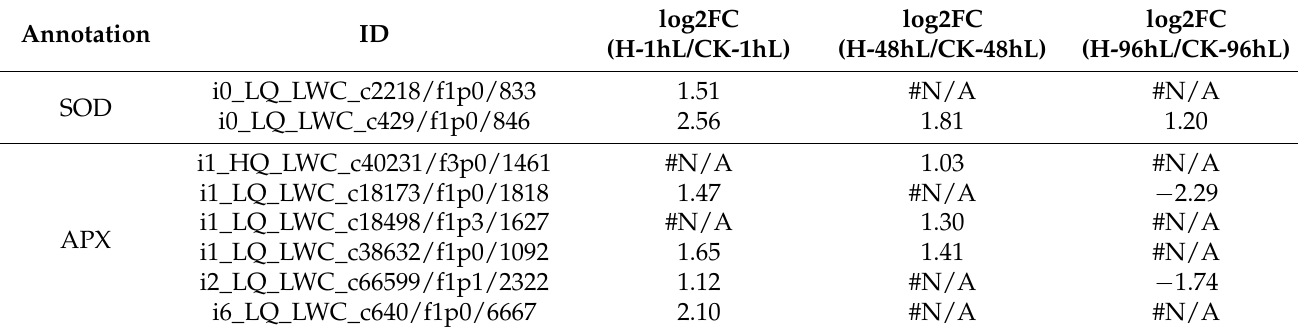
Table 3. Expression of ROS scavenging enzymes in pearl millet under heat stress for 1 h and 48 h. Annotation